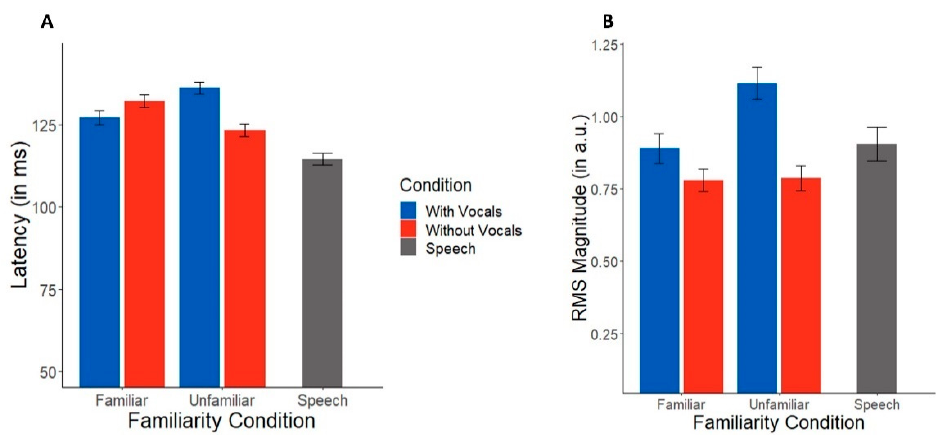
Figure 3. TRF N1 latencies and magnitudes across music masking conditions. ( A ) Latencies were longer for songs with vocals than instrumentals only during unfamiliar music. ( B ) Neural tracking of target speech was also stronger during music with vocals in both familiarity conditions. Error bars represent ± 1 standard error of the mean.